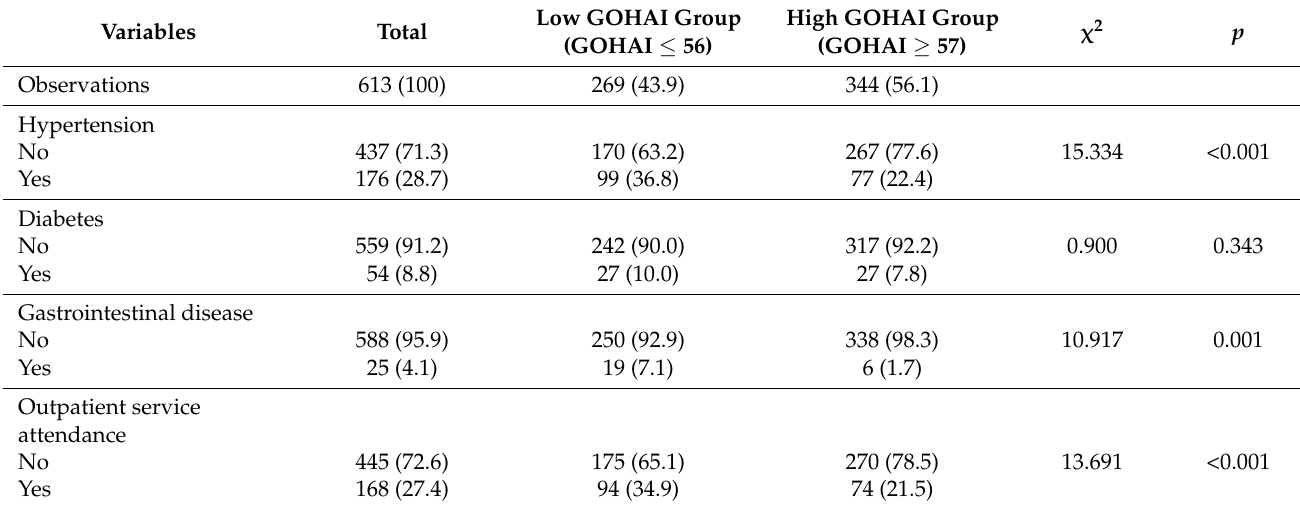
Table 2. Morbidities and GOHAI of the MEFC.